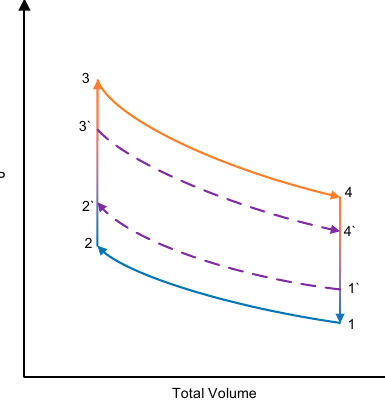
Figure 3. PV diagram of the actual Stirling cycle 1`-2`-3`-4` and ideal isothermal cycle 1-2-3-4 [12].